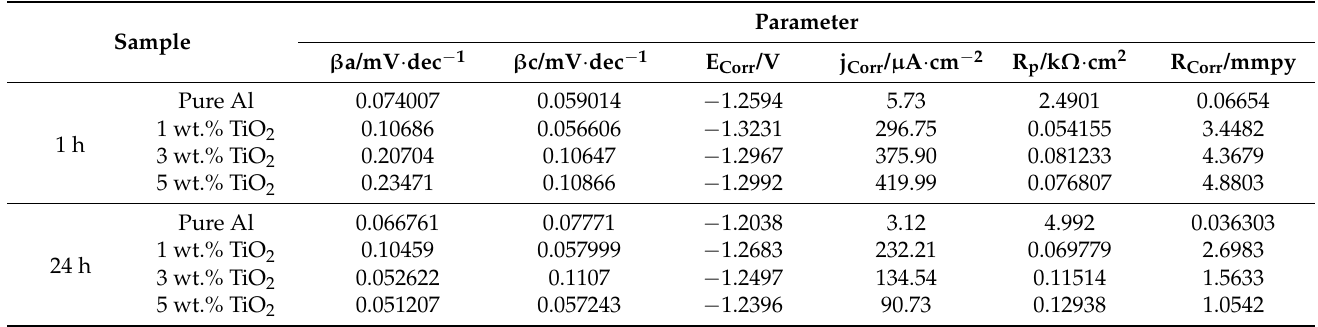
Figure 10. CPP for composite samples exposed for 24-h in 3.5% NaCl solution ( a ) Pure Al, ( b ) 1 wt.% TiO 2 , ( c ) 3 wt.% TiO 2 and ( d ) 5 wt.% TiO 2 . Table 2. Obtained parameters of the composite samples from CPP plots with exposures of 1-h and 24-h in 3.5% NaCl solutions.